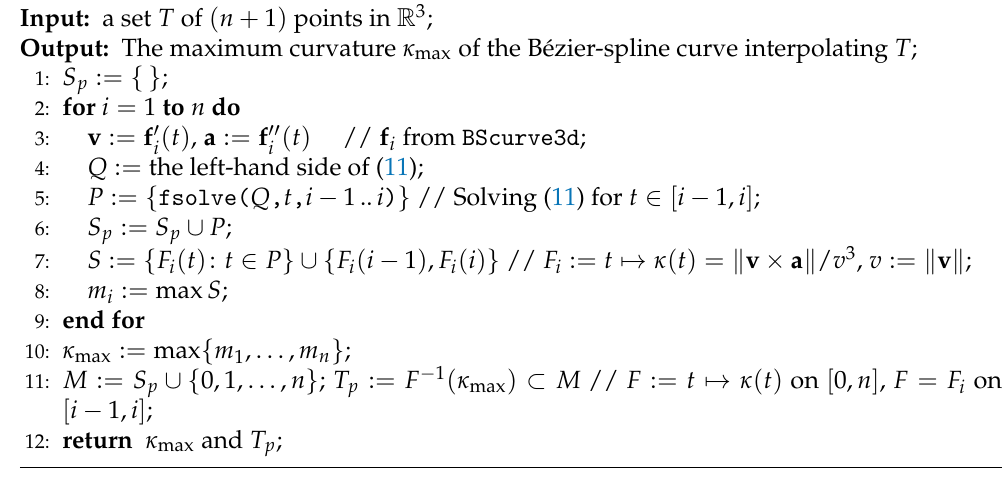
Algorithm 1 Finding the maximum curvature of a Bézier-spline